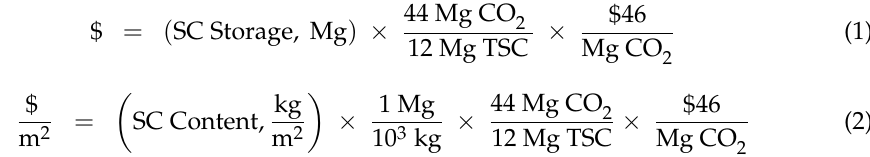
Table 4. Area-normalized content (kg m − 2 ) and monetary values ($ m − 2 ) of soil organic carbon (SOC), soil inorganic carbon (SIC), total soil carbon (TSC) by soil order based on numbers in the upper 2 m of the soil based on data from Guo et al., 2006 [18] and a social cost of carbon (SC-CO 2 ) of $46 per metric ton of CO 2 (2007 U.S. dollars with an average discount rate of 3% [17]).